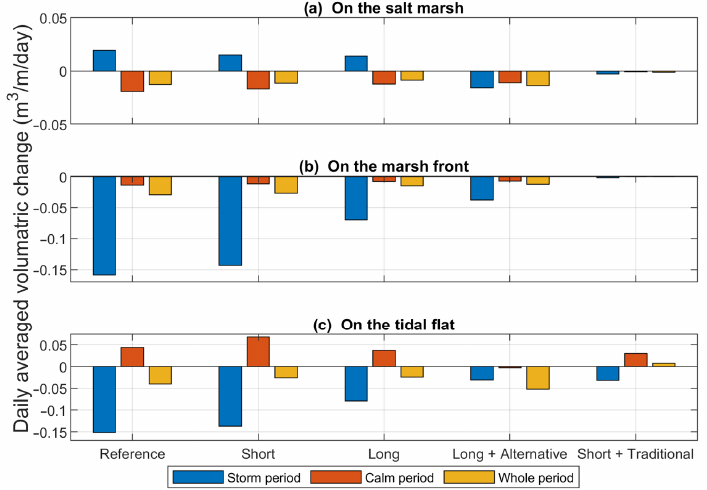
Figure 11. Daily and width averaged simulated volumetric change ( a ) on the salt marsh, ( b ) on the salt marsh front, and ( c ) on the tidal flat. The storm period is the combined bed level change during the storms of 4–5 October and 28–29 October. The calm period is from 9 to 22 October. The whole period is for the whole simulated month. “Reference” displays results of the simulation without artificial structures.